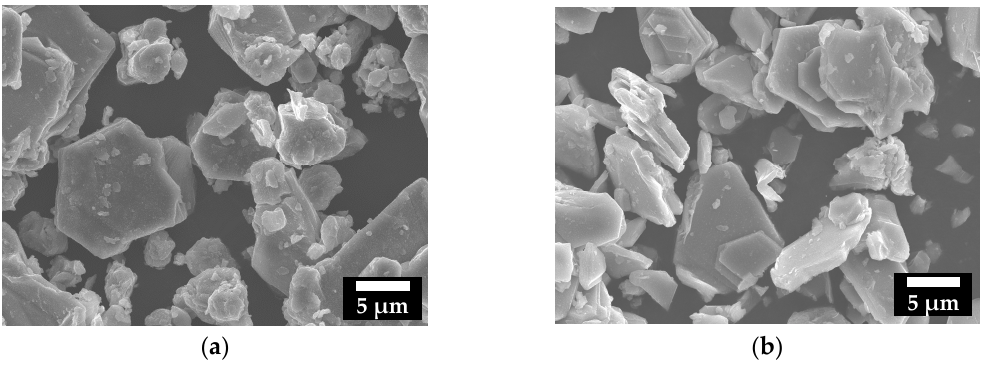
Figure 2. Scanning electron microscopy (SEM) images of ( a ) Na 0.508 Co 0.261 Mn 0.739 O 2 and ( b ) Na 0.50 MnO 2 .